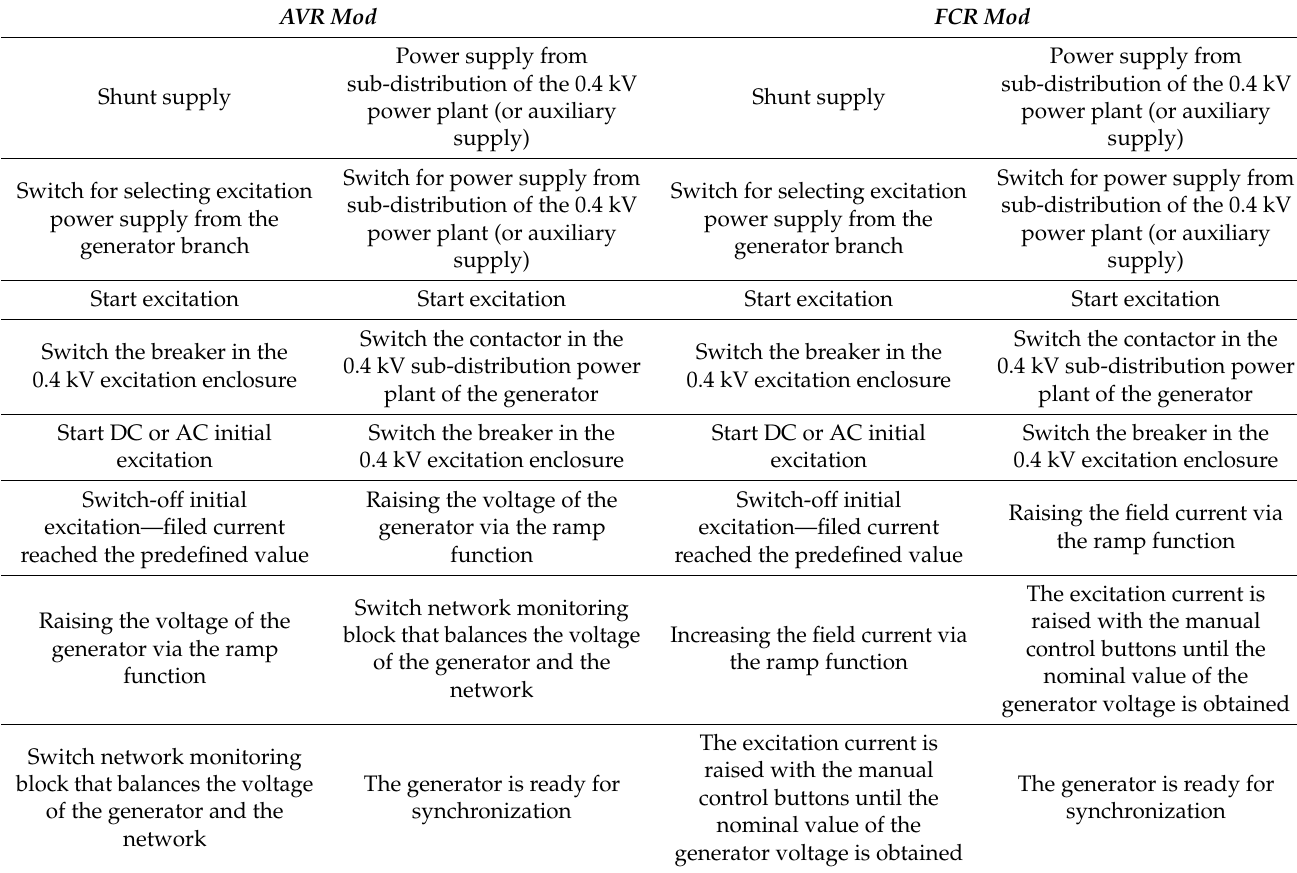
Table 1. The sequence of AVR and FCR